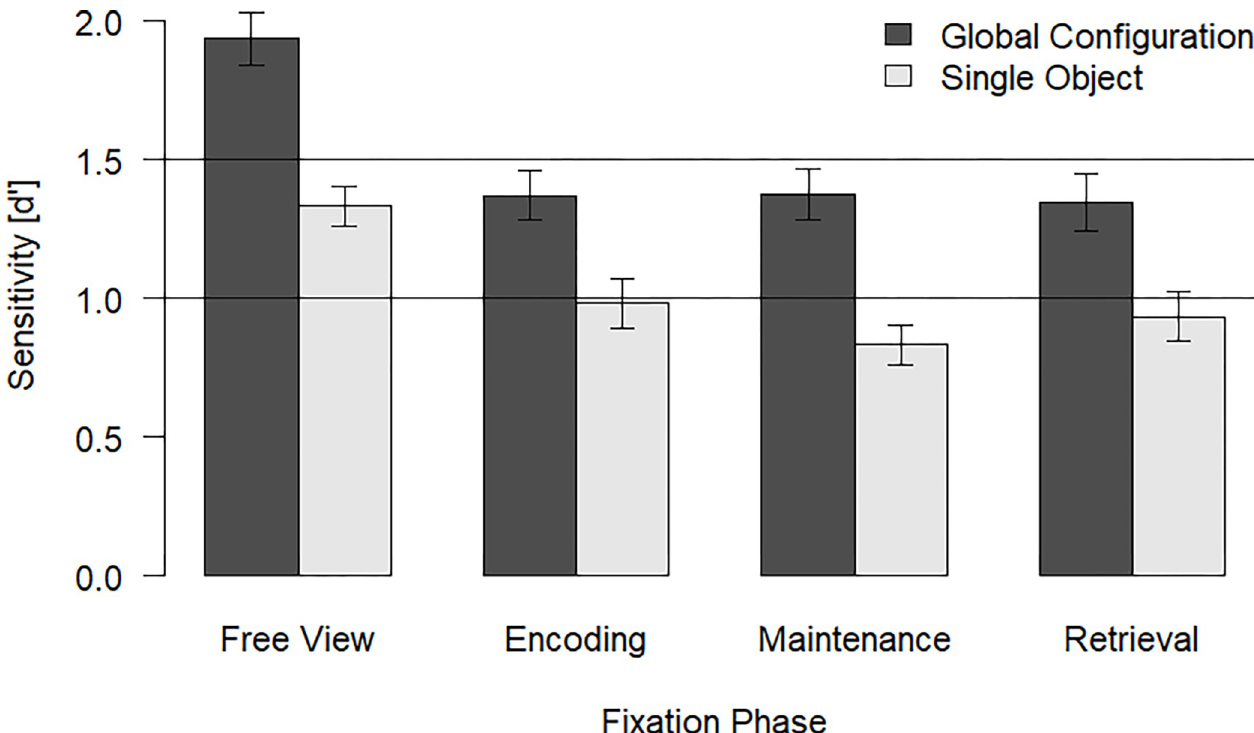
Fig 3. Sensitivity (d’) across conditions for Experiment 2. Error bars indicate the standard error of the mean (SEM).